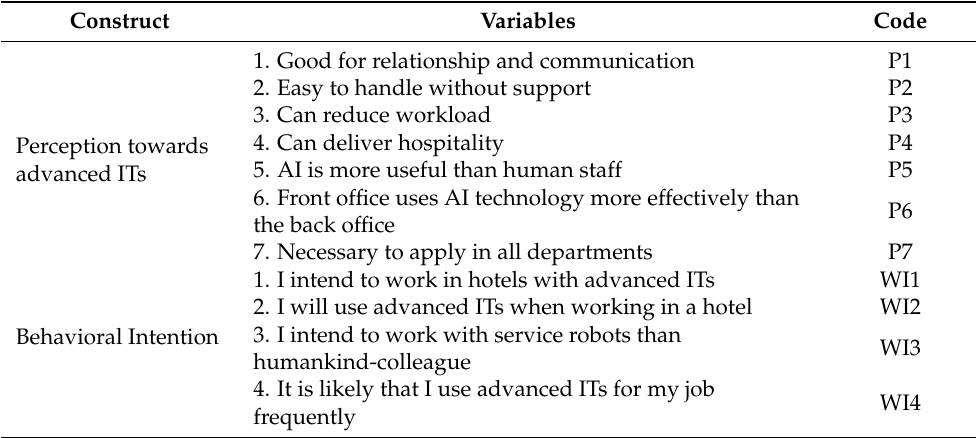
Figure 1. Theoretical framework. Table 1. Perception and work intention